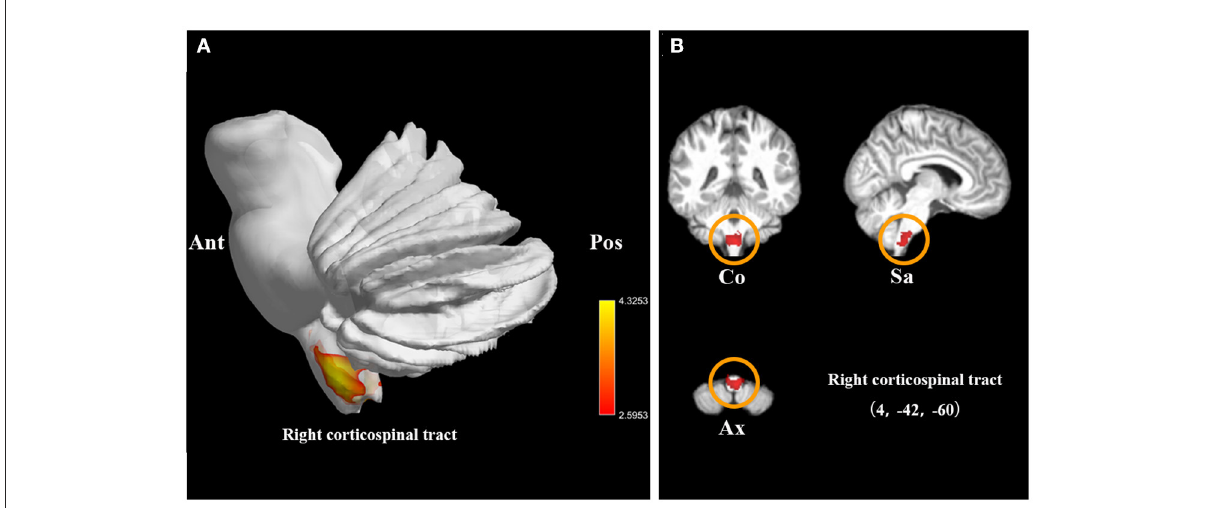
FIGURE3 Statistical parametric maps showing the decreased white matter volumes in patients with spinal cord injury (SCI) compared with those of healthy controls in the pooled meta-analysis. (A) The overlay of statistical parametric maps showing the decreased white matter volume in right corticospinal tract in SCI patients compared with healthy controls. (B) The illustration of the sagittal, coronal, and axial planes of the decreased white matter volume in right corticospinal tract in SCI patients compared with healthy controls. Color bar represents t -value; Co, Sa, and Ax represent coronal, sagittal, and axial planes, respectively. Ant, anterior; Pos, posterior; SCI, spinal cord injury.